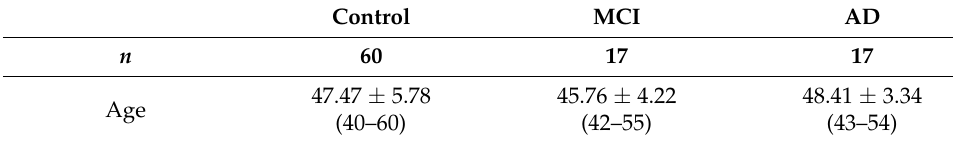
Table 1. Demographic characteristics and cognitive performance by